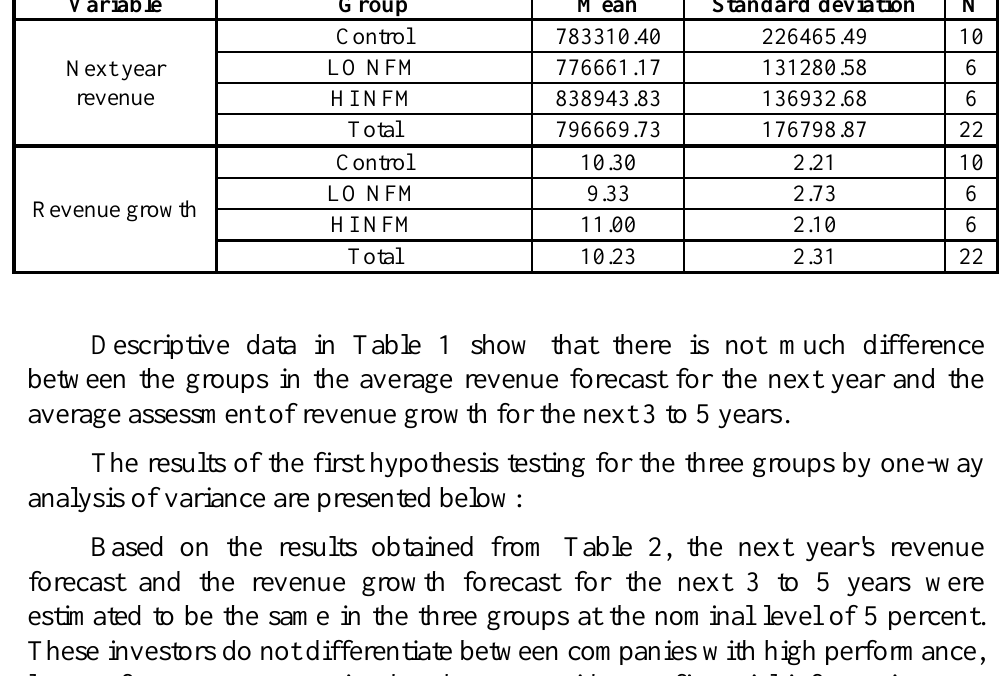
Table 2. One-way ANOVA to compare groups (providing non-financial information alone and